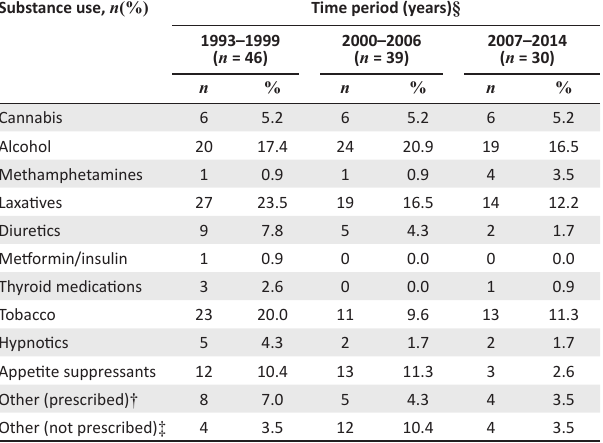
TABLE 3: The changing pattern of substance use amongst patients with eating disorders ( n = 115) between 1993 and 2014. Substance use, n (%)